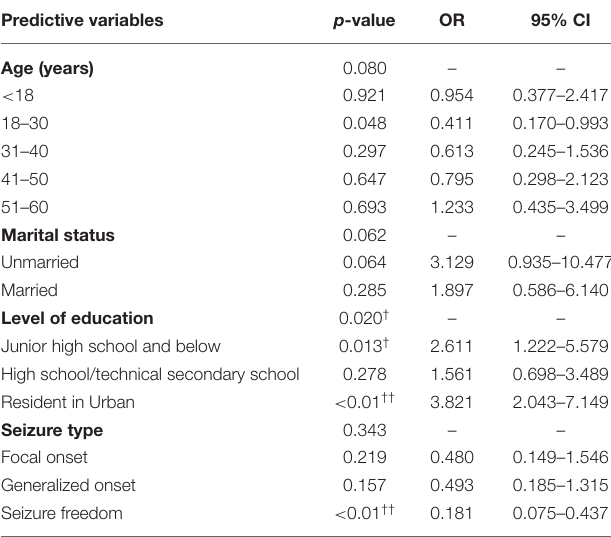
TABLE 4 | Logistic analysis of predictors for taking the willingness to do the COVID-19 vaccine ( n = 427). Predictive